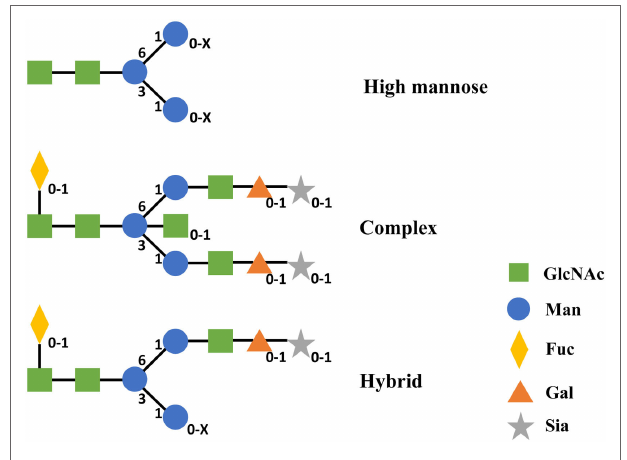
FiGURe 5 | Structures of three categories of N-linked oligosaccharides in IgG1 CH2. Subscripts indicate the absence (0) or presence (1 and X ) of corresponding monosaccharide. X represents a number that is equal or greater than 1 of this monosaccharide. Abbreviations: Gal, galactose; GlcNAc, N -acetylglucosamine; Man, mannose; Fuc, fucose; Sia, sialic